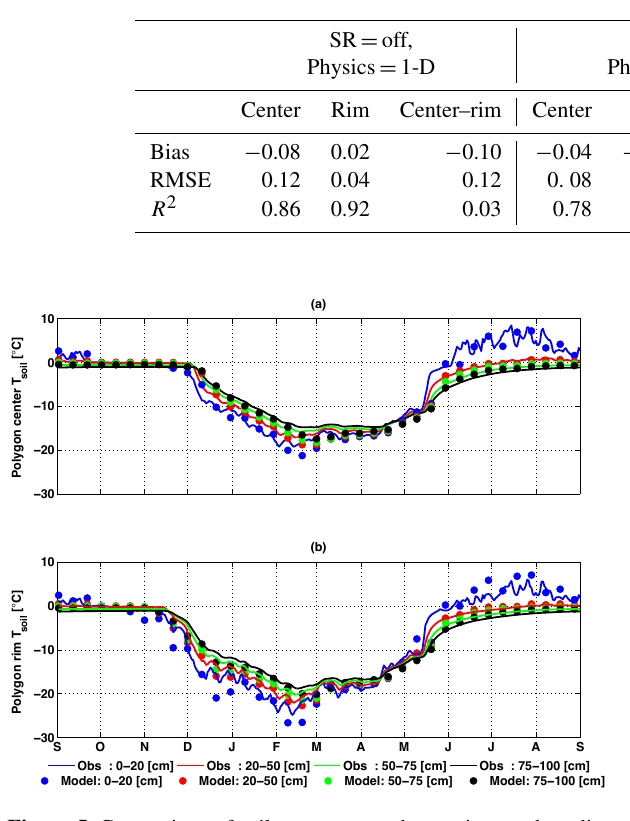
Figure 5. Comparison of soil temperature observations and predic- tions in polygon centers (a) and rims (b) . Simulation was performed with snow redistribution on and 2-D subsurface physics, between September 2012 and September 2013. Simulation results are shown at an interval of 10 days, while observations are shown at a daily